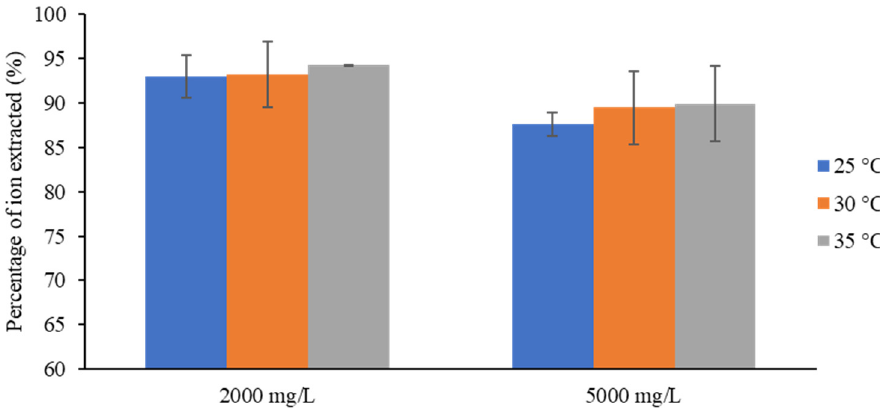
Figure 8. Effect of inlet temperature on removal efficiency in the experiments at 20 V.